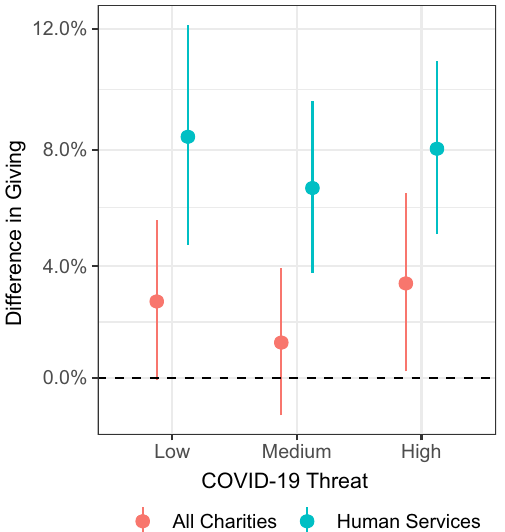
Figure 2. Charity Navigator donations. The vertical axis captures the difference between giving under threat relative to no threat (dashed line). The horizontal axis indicates threat levels in each participant’s county at the time of the donation. Points and error bars represent regression coefficient estimates and 95% confidence intervals, respectively. Note the “All charities” category includes human services charities.